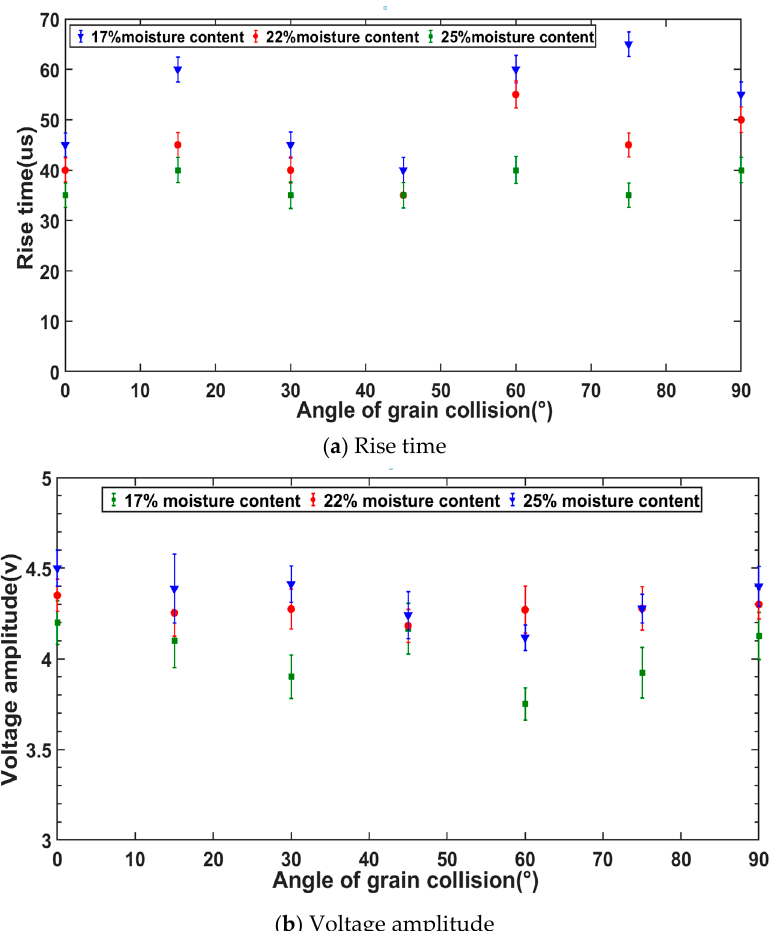
Figure 9. Variation in rise time and voltage amplitude under different collision angles for grains with different moisture